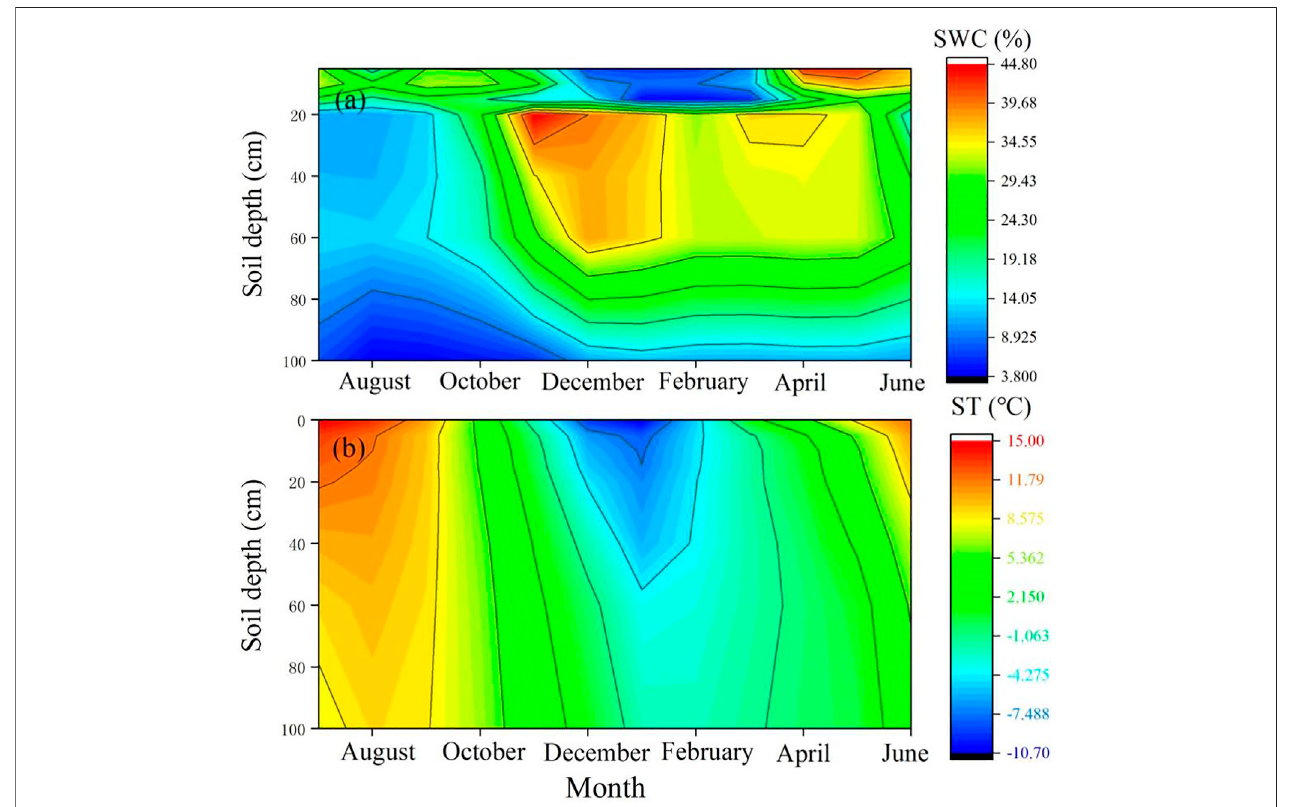
FIGURE 6 | Seasonal variation of soil moisture (A) and soil temperature (B) across different soil